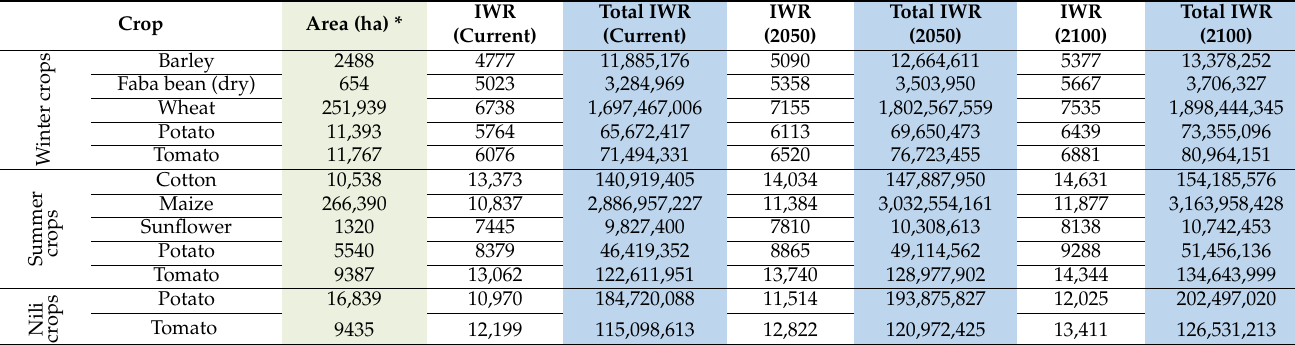
Table 1. Total irrigation water requirements (IWR, m 3 ) for some main crops in the old lands of Middle Egypt under current and climate change conditions.